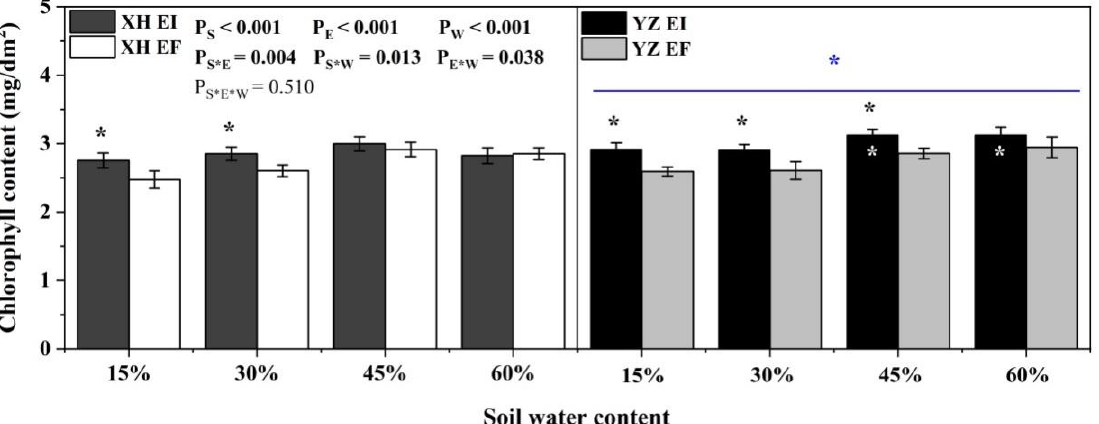
Figure 5. The chlorophyll content of A. inebrians seedlings shoots from XH(W) and YZ(D) seeds under various soil water content (mg/dm 2 ). The asterisk (*) above/below error bars means significant difference ( p < 0.05) between EI and EF under the same soil water content. White * in the black bars indicates significant difference ( p < 0.05) between Xiahe and Yuzhong maternal habitat type of EF/EI grasses. The blue * above/below full blue line indicates significant difference ( p < 0.05) between Xiahe and Yuzhong maternal habitat